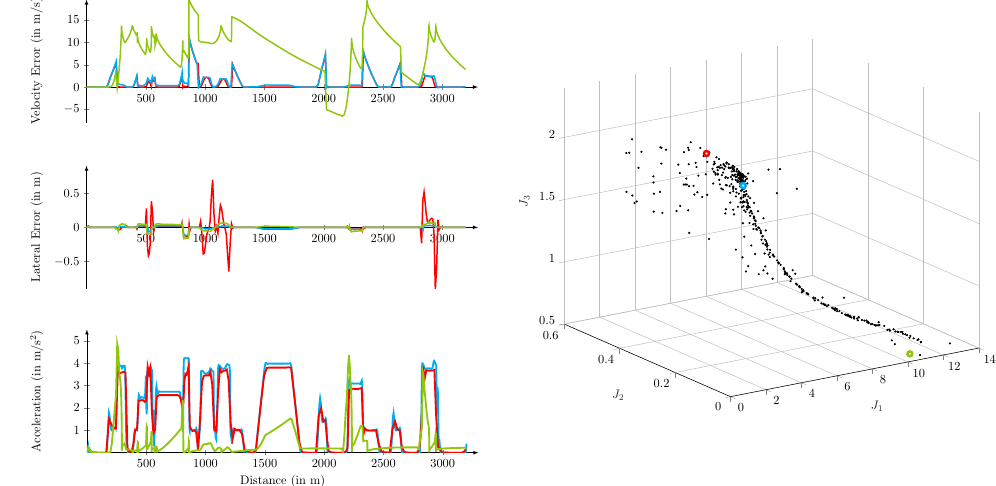
Figure 7. ( Left ) Time-domain plot for three different Pareto-optimal MPC parameterizations. The green, blue and red parameterizations focus on minimizing acceleration, lateral error, and velocity error, respectively. ( Right ) Corresponding objective Pareto front, where the parameterizations shown in the left image are marked in the equivalent colors: minimizing acceleration (green dots), lateral error (blue dots) and velocity (red dots). All other parameterizations on the Pareto front (black dots) represent alternative non-dominated